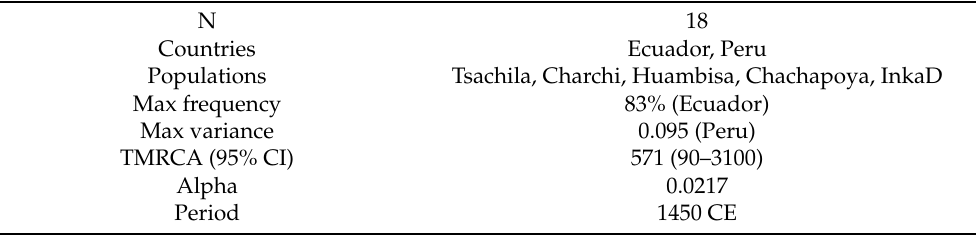
Table 1. Principal features of Descent Cluster 6 (DC6), including the number of microsatellite profiles, the countries, and the populations where the cluster expanded, the maximum values of frequency and variance, the TMRCA estimates, the growth generational growth rate ( α ), and the period that the cluster dates back